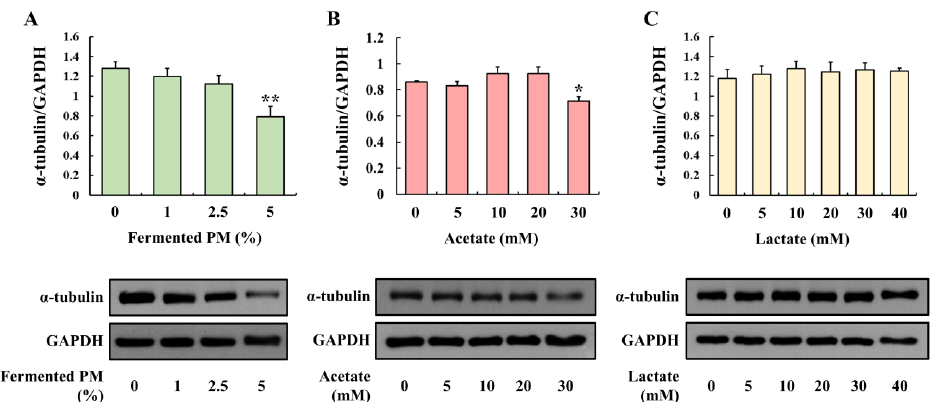
Figure 6. Effect of fermented PM, acetate, and lactate on microtubule protein expression in Caco-2 cells. Protein expression of α -tubulin treated with ( A ) fermented PM, ( B ) acetate, and ( C ) lactate in Caco-2 cells. The cells were treated with fermented PM (0, 1, 2.5, and 5%), acetate (0, 5, 10, 20, and 30 mM), and lactate (0, 5, 10, 20, 30, and 40 mM) for 48 h ( n = 3 wells per groups). GAPDH was used as the housekeeping protein. Images are representative of three independent experiments. Results are expressed as mean ± standard error ( n = 3). * ( p < 0.05) and ** ( p < 0.01) indicate significant differences compared with the control (0% and 0 mM).